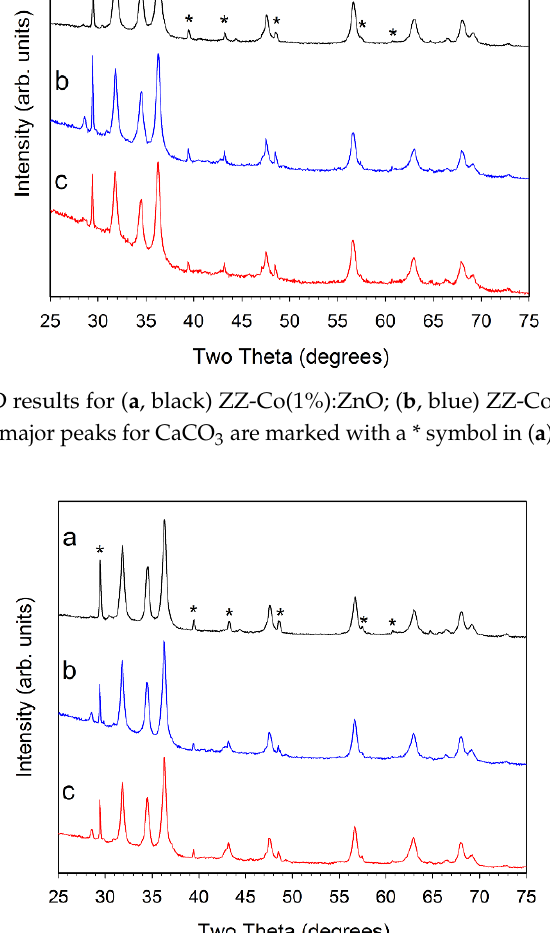
Table 1. Summary of key results for ZZ leaf templated ZnO materials.